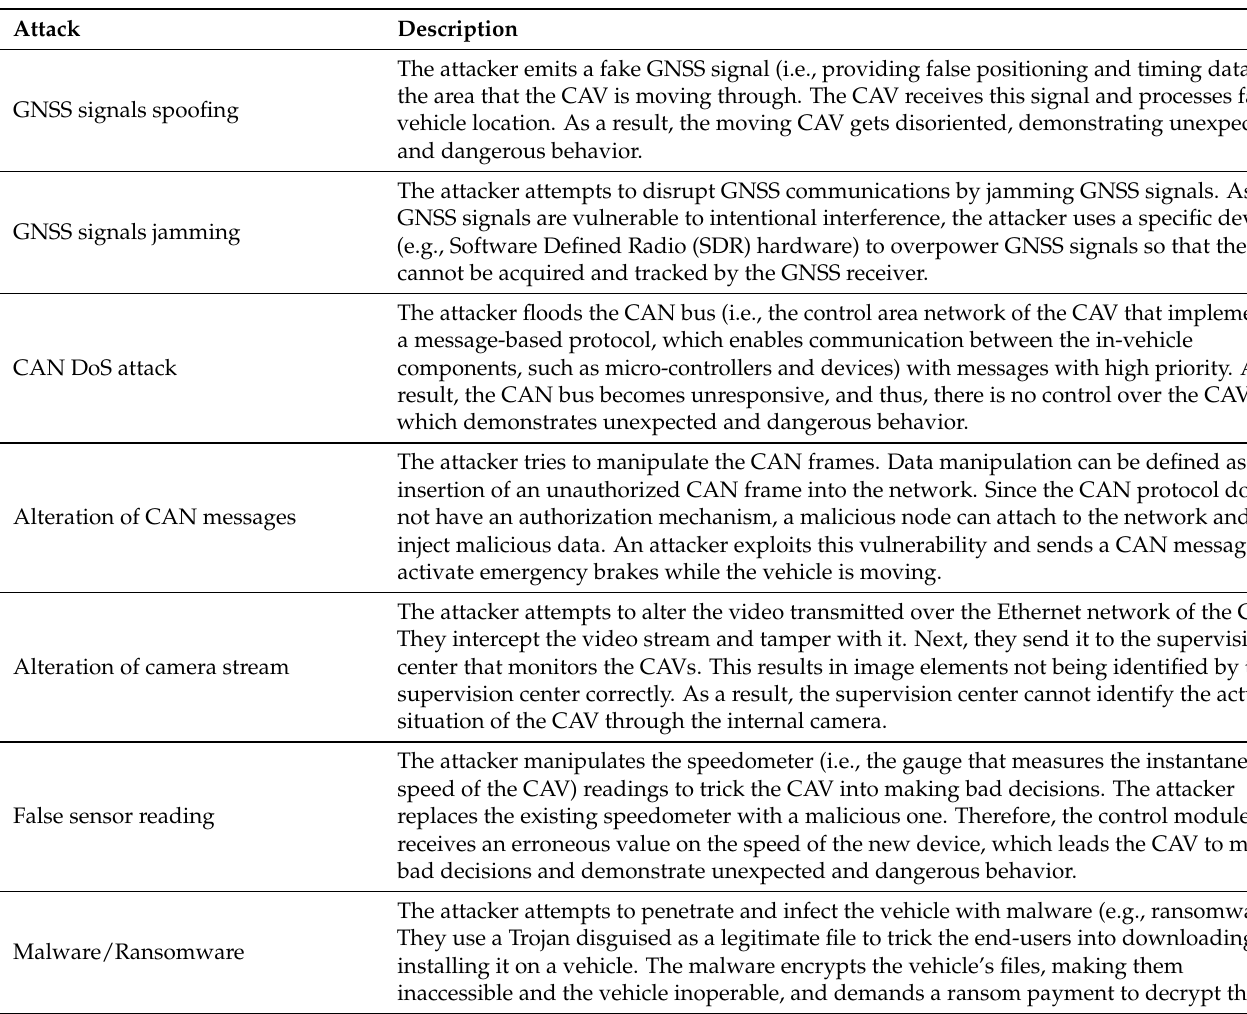
Table 2. The attack scenarios performed in our